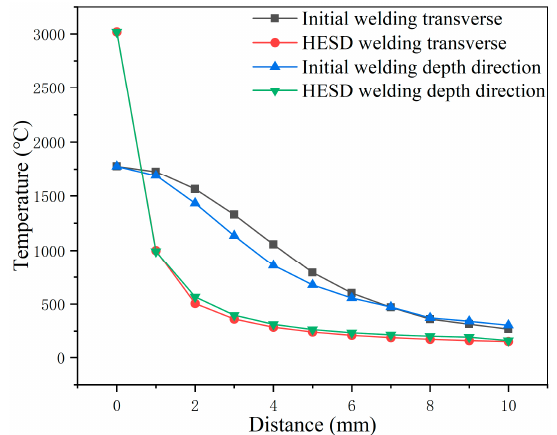
Figure 14. Temperature curves in the transverse and depth directions.